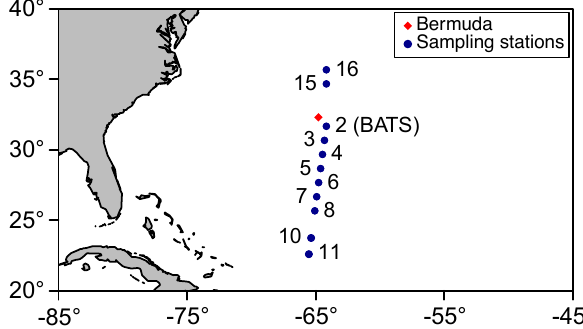
Fig. 1. Map of sampling stations in the North Atlantic subtropical gyre during the BV47 cruise in 2012. The BATS site corresponds to station 2. All samples were collected from surface water